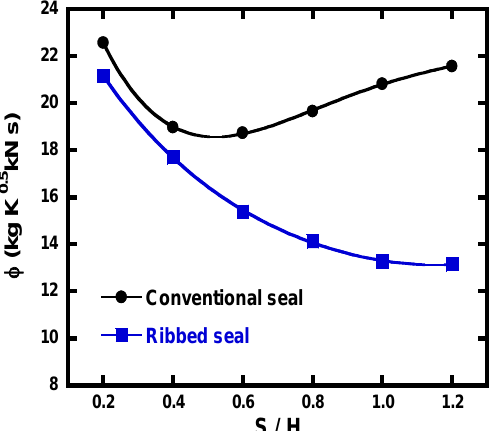
Figure 8. Variation in the flow function with S/H (PR = 2.5, t/K = 0.1, β = 90°).